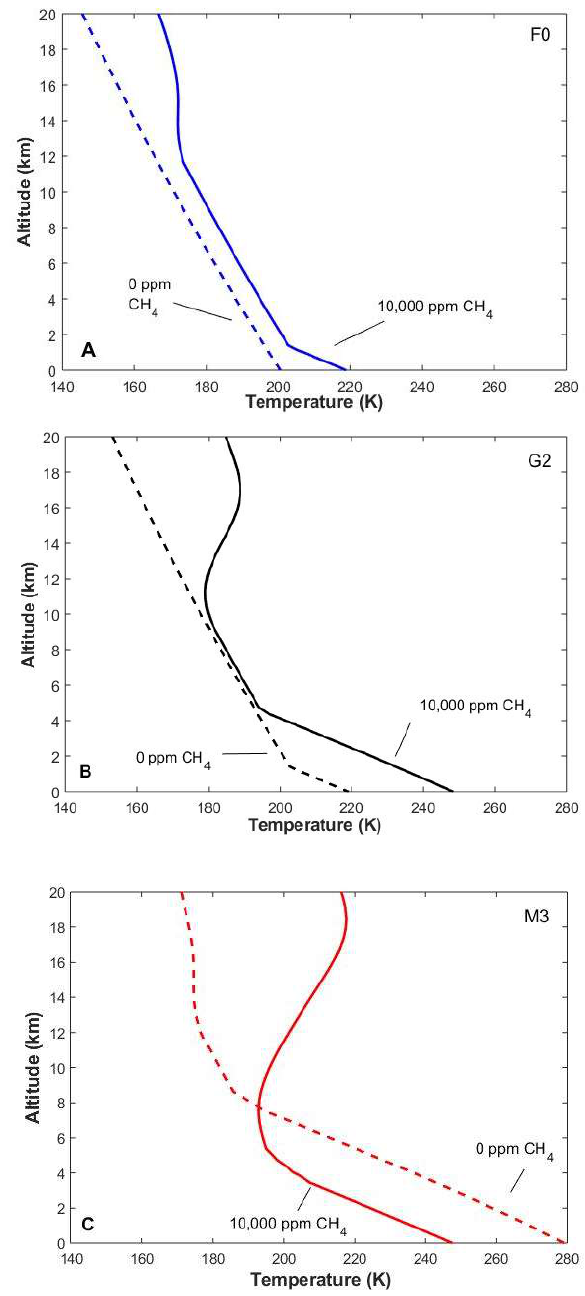
Figure 7. Changes in temperature profiles for a 3-bar CO 2 (1 bar N 2 ) atmosphere (solar energy =33% that received by the Earth) for a model planet orbiting an F0 (blue) ( A ), ( B ) a G2 (black; solar-analog), and ( C ) an M3 (red) host star with and without 1% (10,000 ppm) CH 4 . A temperature inversion forms for all three planets. The surface temperature increases when CH 4 is added on the planet orbiting the F0 (18 K) and solar (G2) analog (29 K), but decreases for the planet orbiting an M3 star (31 K). Adapted from Ramirez and Kaltenegger [2] and updated from Ramirez [22].